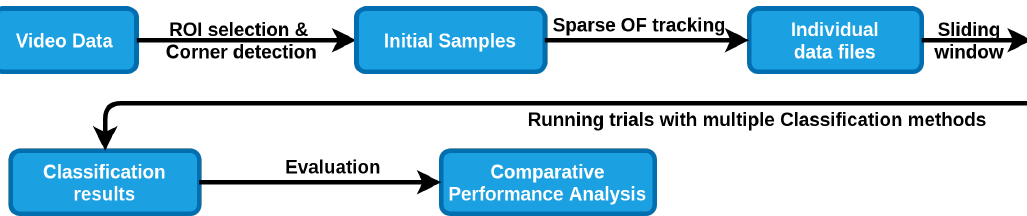
Figure 1. The proposed workflow: First, we compute and save the initial samples from each video input using user-selected regions of interest. Then, by tracking them with the sparse Lucas–Kanade OF—tracking the movement of both surgical tools independently—we process the videos, creating data files that are further processed by a sliding window method, outputting the final input data. Using several different classification methods, we determine the users’